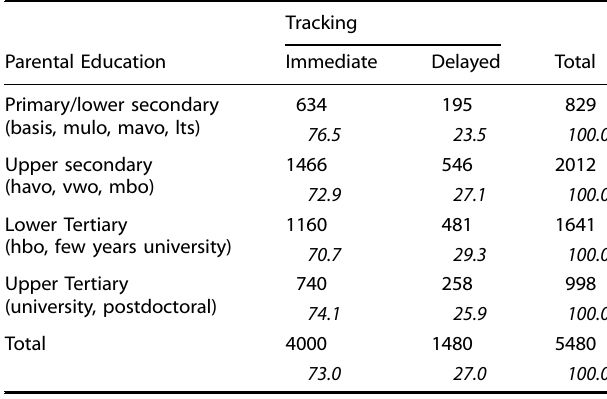
Table 3. Number and percentage with immediate and delayed tracking by parental education.